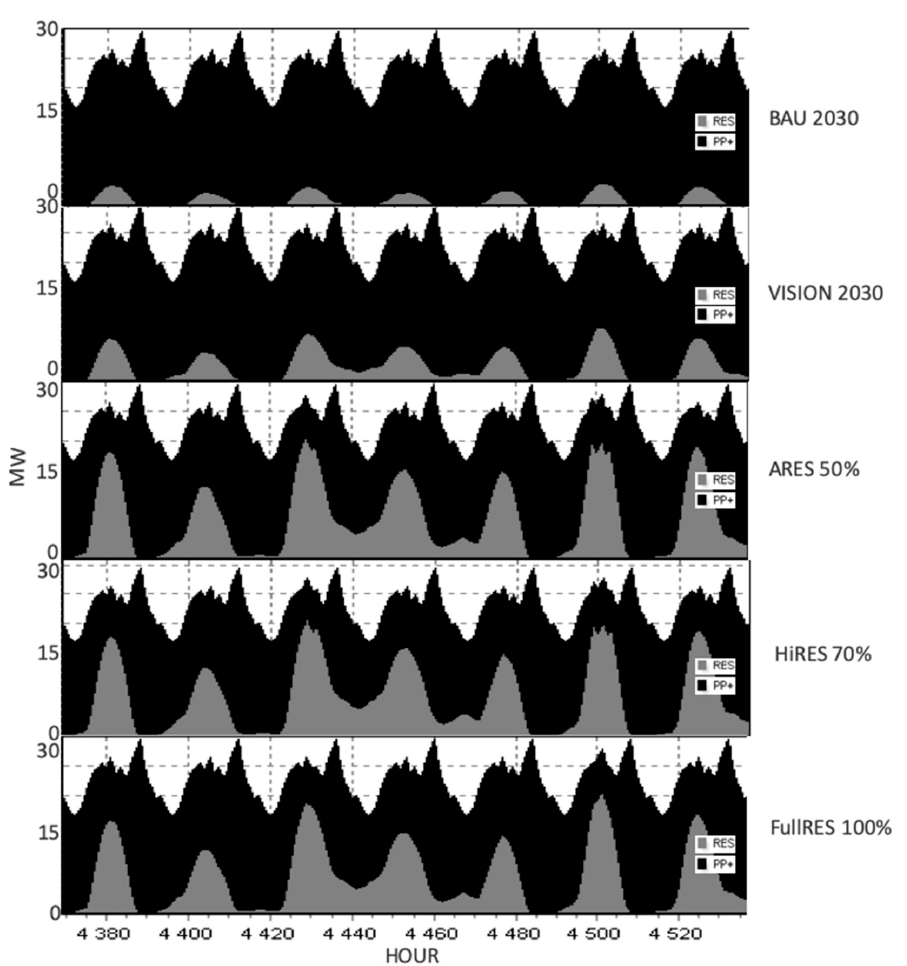
Figure 11. Electricity production capacity with different sources in 1–7 July 2019 in Isla de la Juventud. (RES (in gray) and Power Plants, PP+ (in black) with 100% diesel and fuel oil in BAU 2030 and Vision 2030 and 10%, 43%, and 100% of biofuel share in ARES, HiRES, and FullRES, respectively). Energies 2021 , 14 , x FOR PEER REVIEW